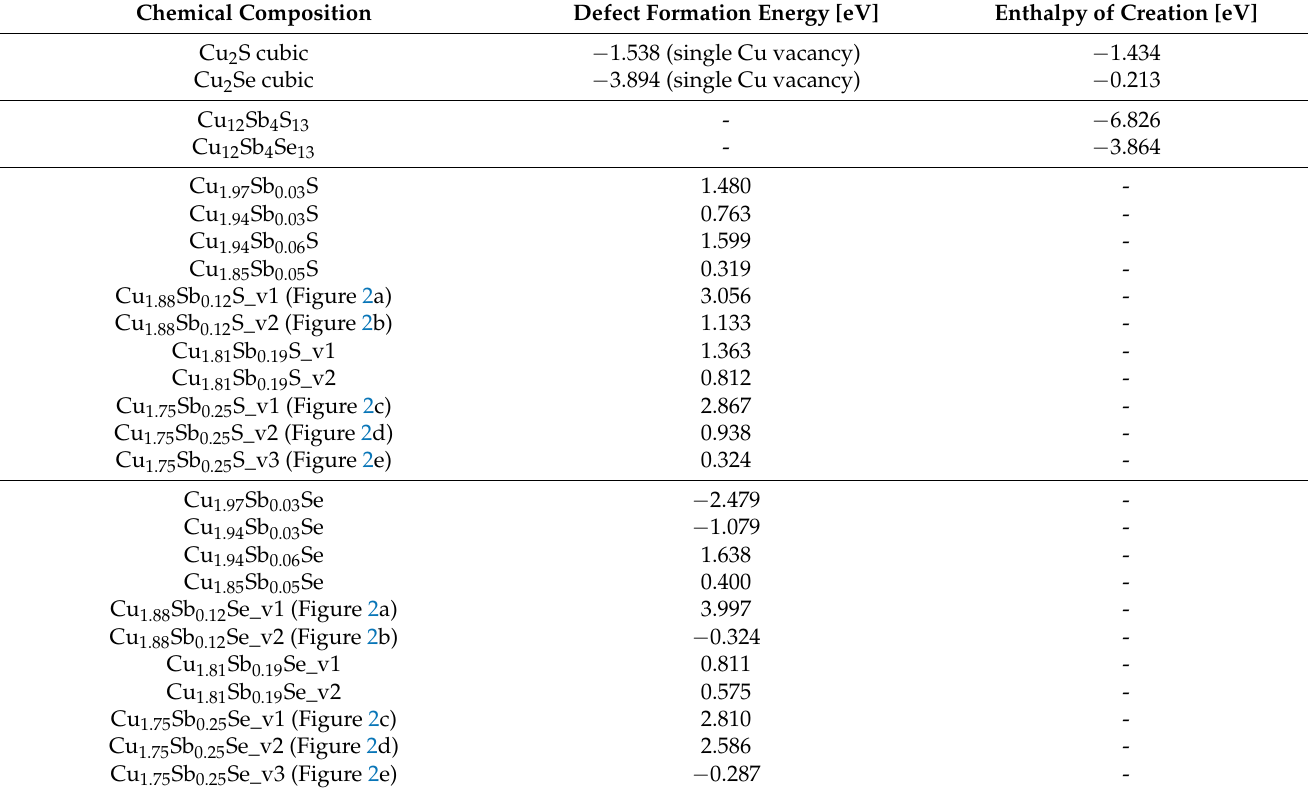
Figure 2. Optimized model structures: ( a ) Cu 1.88 Sb 0.12 Ch_v1, ( b ) Cu 1.88 Sb 0.12 Ch_v2, ( c ) Cu 1.75 Sb 0.25 Ch_v1, ( d ) Cu 1.75 Sb 0.25 Ch_v2, ( e ) Cu 1.75 Sb 0.25 Ch_v3, ( f ) Cu 12 Sb 4 Ch 13 . Table 2. Defect formation energies and enthalpy of creation determined on the basis of optimized model structures and Equations